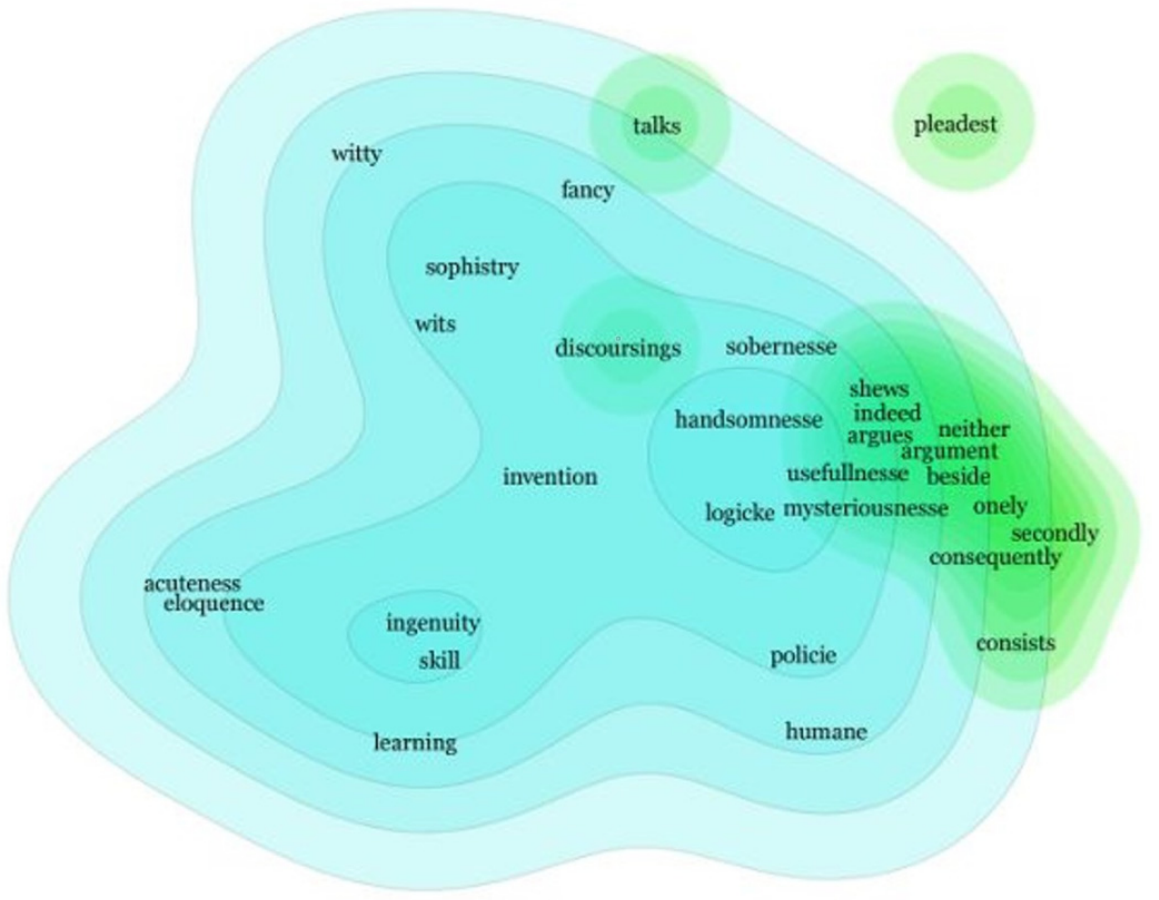
Figure 9. Semantic neighborhood of wit . M. Gavin et al. Spaces of Meaning: Conceptual History, Vector Semantics, and Close Reading. In Debates in Digital Humanities ; Gold, M., Klein, L. F.; University of Minnesota Press: Minneapolis, 2019.